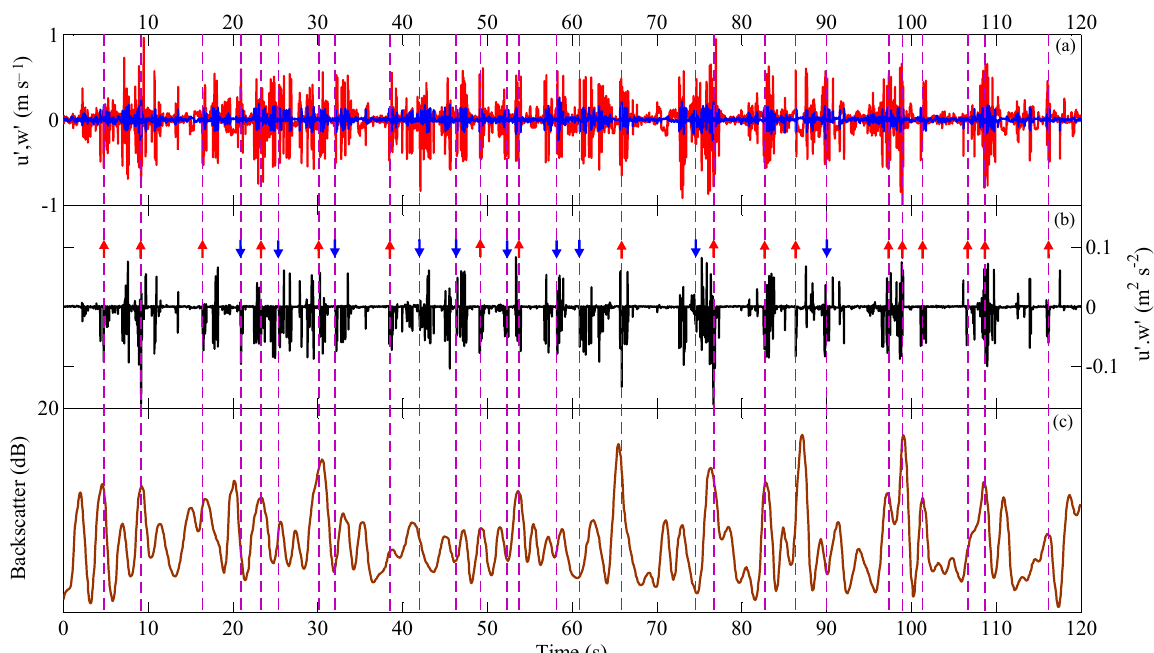
Figure 4. Time series records from above the measured mean critical velocity experiment ( u > u cr,measured ): (a) turbulent velocity ( u (cid:48) , red in colour; w (cid:48) , blue in colour); (b) turbulent Reynolds shear stress ( u (cid:48) w (cid:48) ), showing the ejection (red upward arrows) and sweep (blue downward arrows) events; (c) 1s mean of the backscatter.